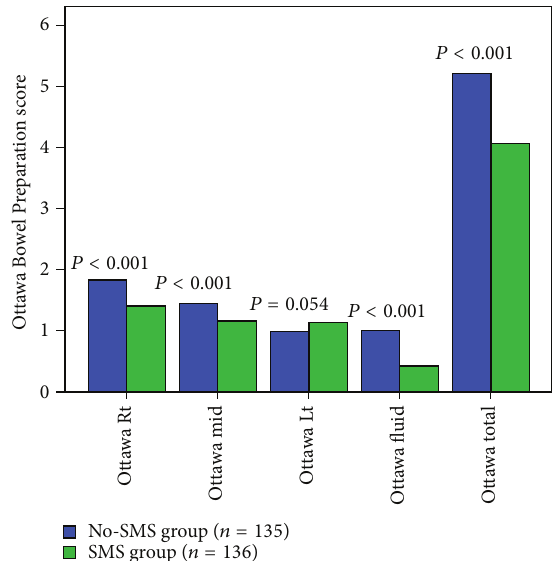
Figure 2: The association of bowel preparation quality with the PC interval and intervention using SMS. Ottawa Rt is Ottawa score of the right colon (cecum, ascending colon). Ottawa mid is Ottawa score of the midcolon (transverse, descending colon). Ottawa Lt is Ottawa score of the left colon (the rectosigmoid colon). Ottawa fluid is the fluid quantity of the entire colon. PC interval, preparation-to- colonoscopy interval; SMS, short message service of cellular